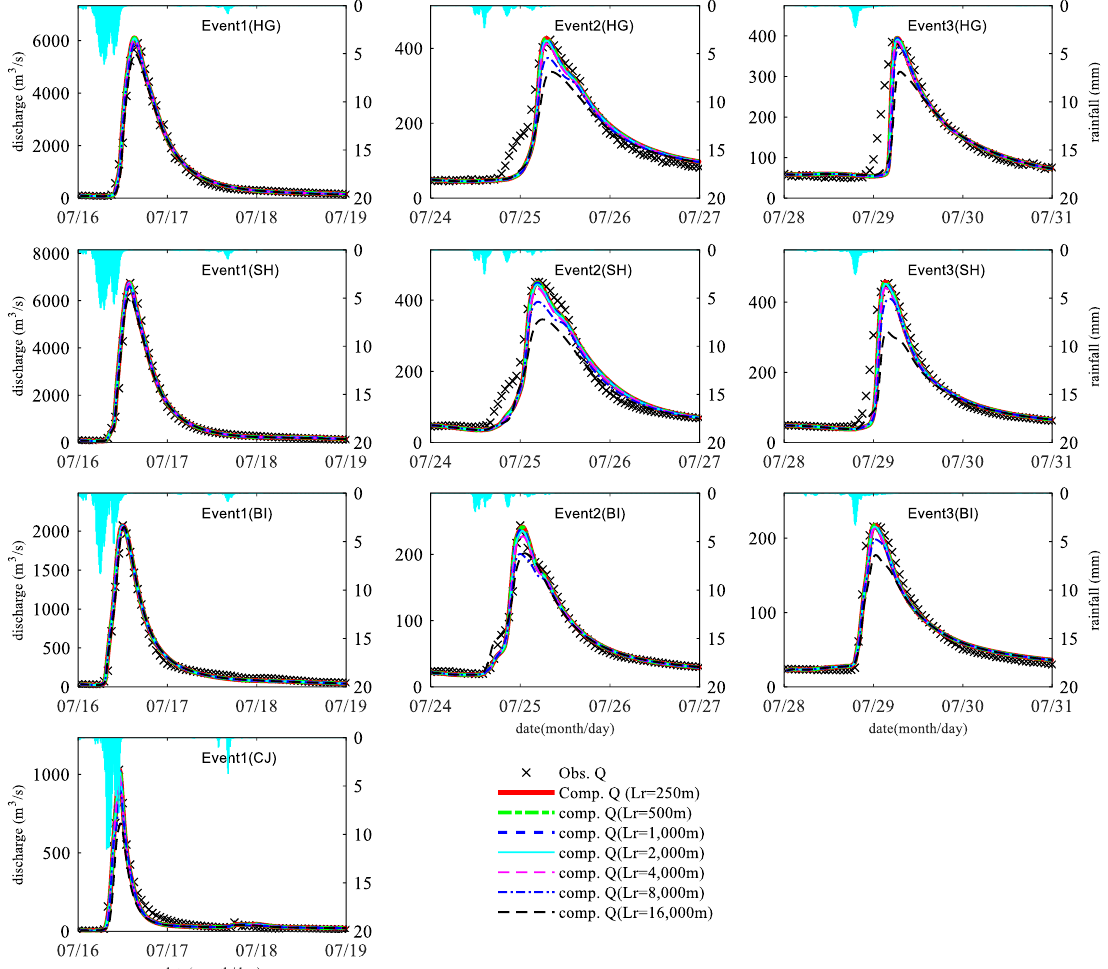
Figure 4. Measured and computed runoff hydrographs with 𝑇 𝑟 = 10 min . Vertical cyan bar represents rainfall (mm).